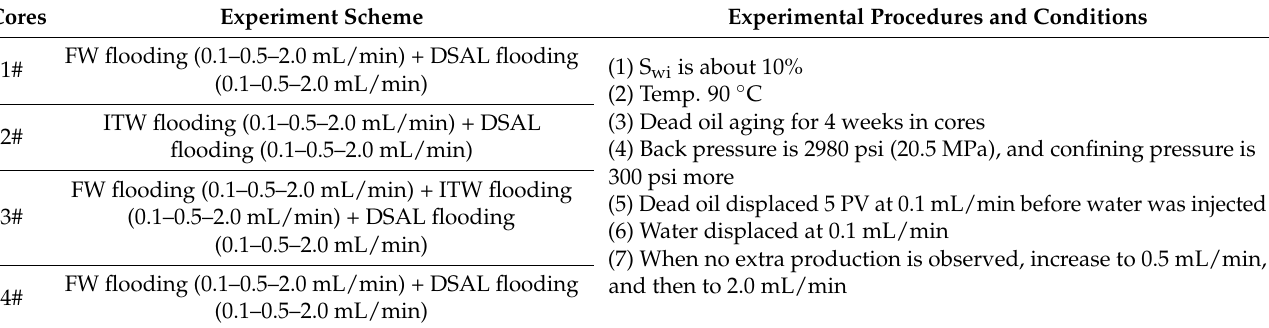
Table 4. Main parameters of core-flooding